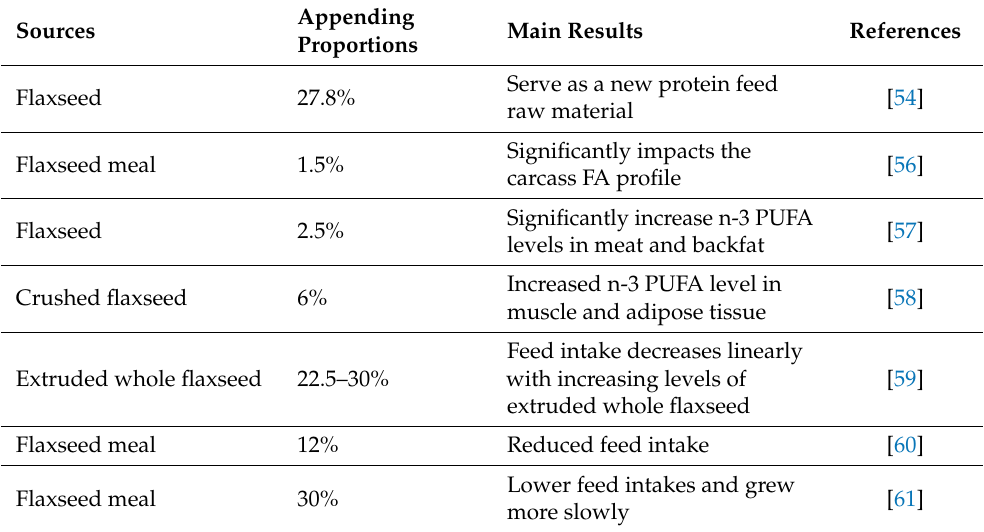
Table 4. Application of flaxseed and flaxseed meal in growing